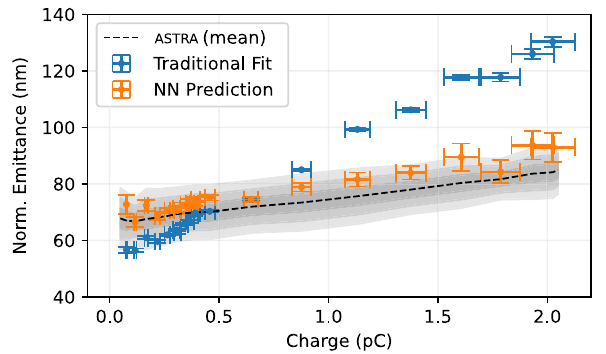
FIG. 9. Emittance measurements were conducted at the ARES linac at DESY using the phase advance scan technique for different bunch charges. The black dashed line denotes the mean ASTRA simulation result. The shaded areas correspond to the 1, 2, and 3 σ uncertainty of the simulation, based on 100 simulations with normally distributed input